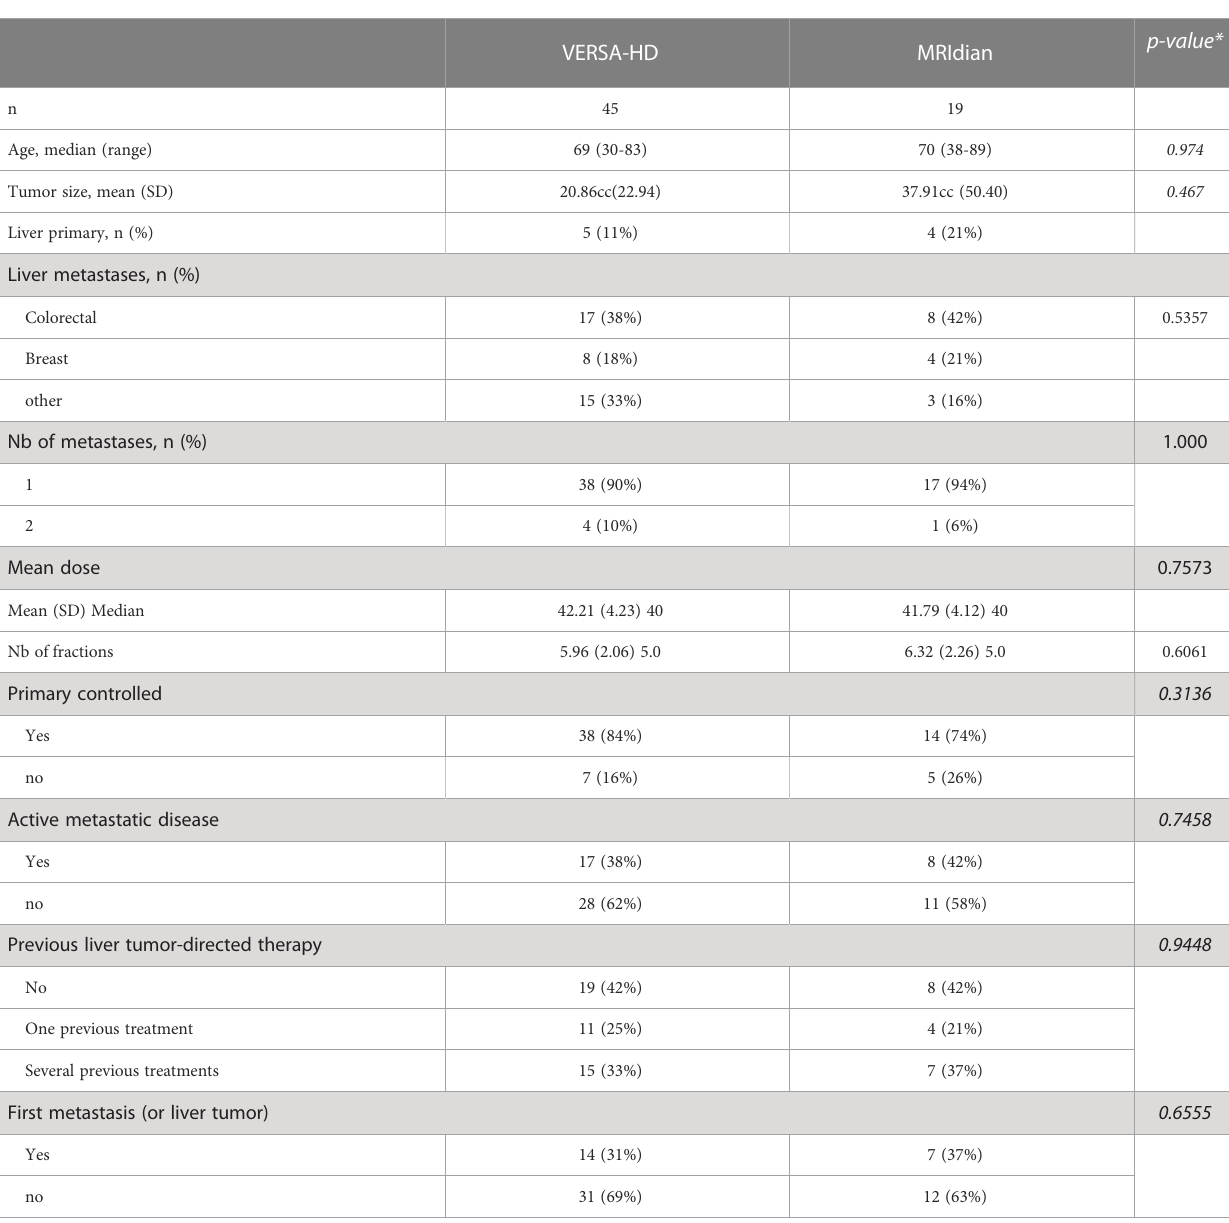
TABLE 2 Patient